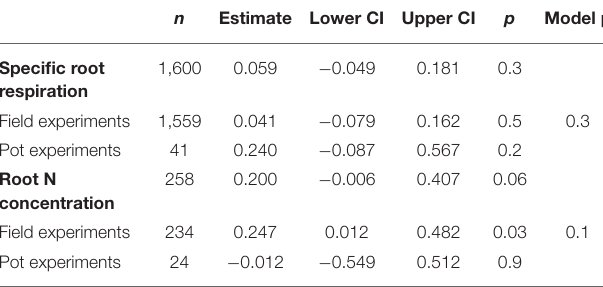
TABLE 1 | Effect sizes (LnRR) of specific root respiration (SRR) and root N concentration to N fertilisation for all observations and separated by field and pot experiments.